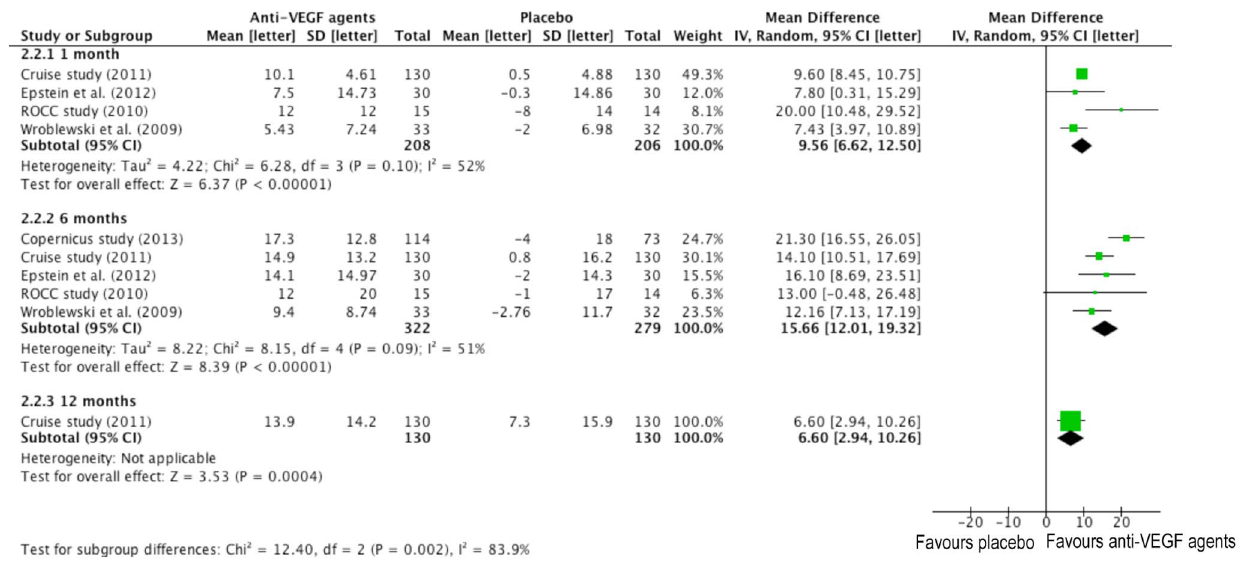
Figure 4. Forrest plots for the mean visual acuity change on Early Treatment in Diabetic Retinopathy Study (ETDRS) Chart at one, six and twelve months between anti-VEGF and placebo group.